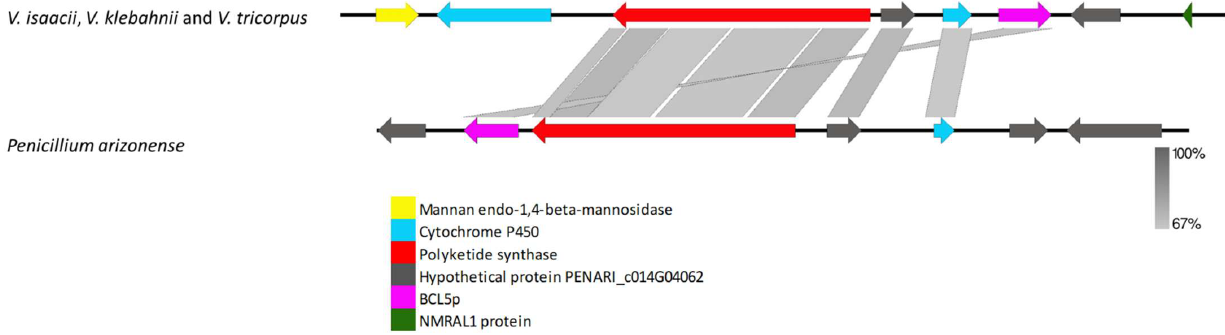
Figure 7. Comparison of putative cluster genes for VRPKS-I-20 locus found in the genomes of V. isaacii, V. klebahnii and V. tricorpus and an unknown PKS cluster from Penicillium arizonense. The arrowheads indicate the direction of transcription and the types of genes common between the two clusters being compared are displayed in the same color. Shaded lines represent similarities between nucleotide sequences.